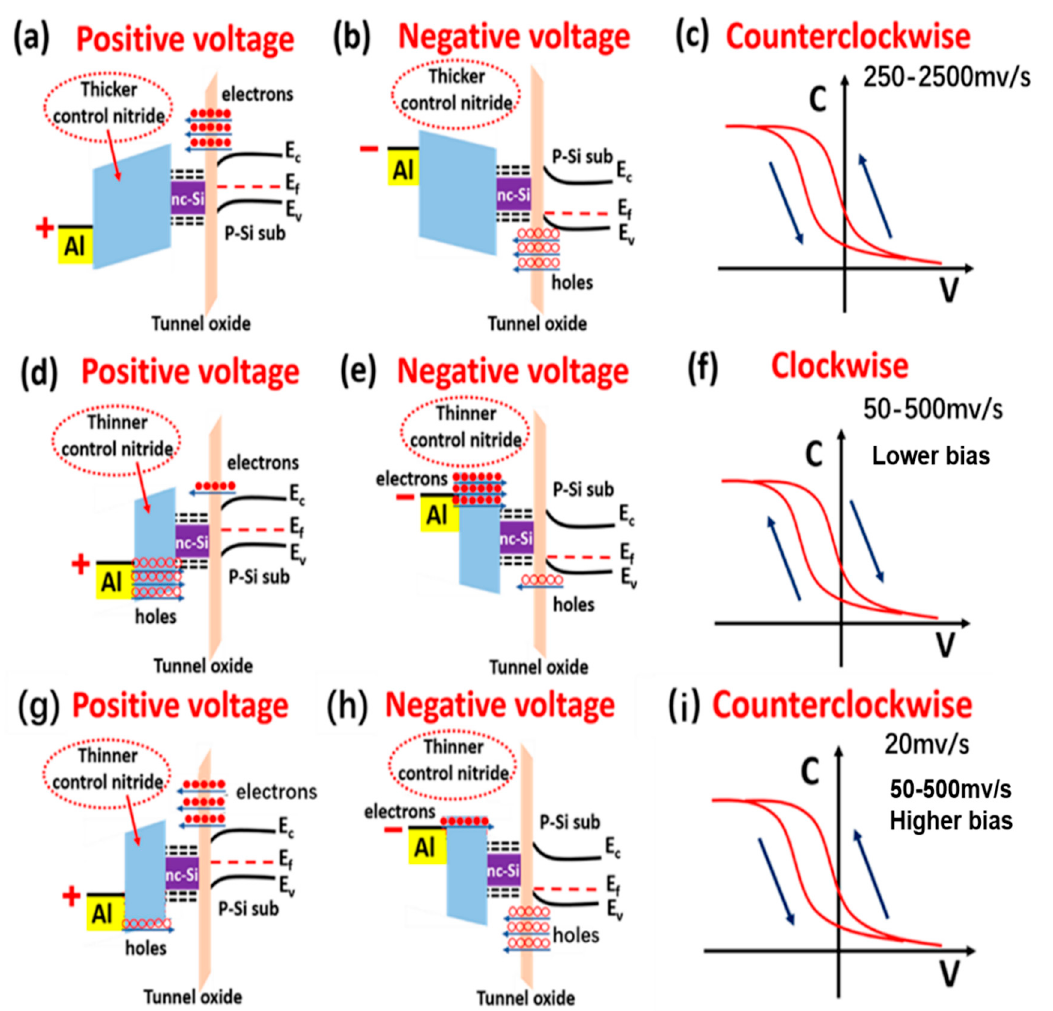
Figure 5. The energy band gap model of the SiN x /nc-Si/SiO 2 floating-gate MOS structure with thicker SiN x control layer under ( a ) positive and ( b ) negative voltages. ( c ) The counterclockwise hysteresis memory window of the SiN x /nc-Si/SiO 2 floating-gate MOS structure with step size from 250 to 2500 mv/s. The energy band gap model of the SiN x /nc-Si(a-Si)/SiO 2 floating-gate MOS structure with the thinner control SiN x layer under ( d ) positive and ( e ) negative voltages. ( f ) The clockwise C–V hysteresis memory window of the SiN x /nc-Si/SiO 2 floating-gate MOS structure with the step size from 50 to 500 mv/s. The energy band gap model of the SiN x /nc-Si(a-Si)/SiO 2 floating-gate MOS structure with the thinner SiN x control layer under ( g ) positive and ( h ) negative voltages. ( i )The counterclockwise C–V hysteresis memory window of the SiN x /nc-Si/SiO 2 floating-gate MOS structure with the step size of 20 mv/s. The hollow circles and solid circles represent the holes and electrons, respectively.